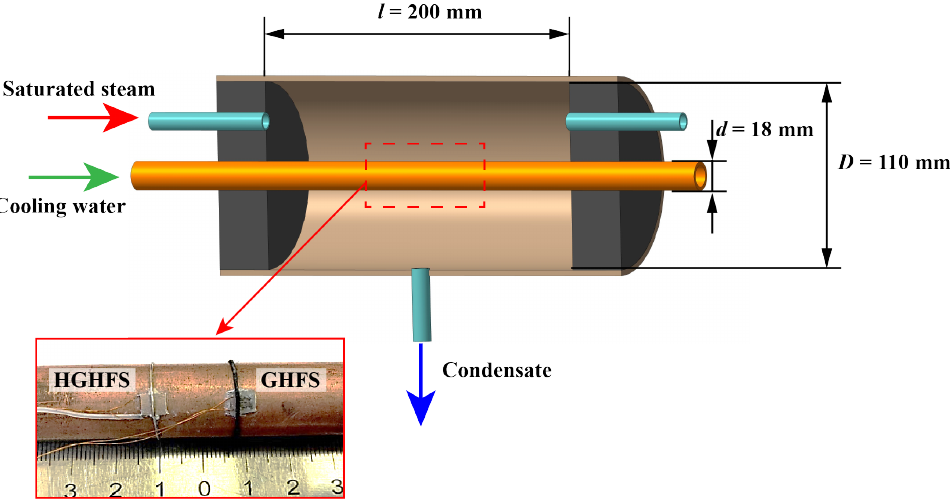
Figure 2. The experimental setup for GHFS-type